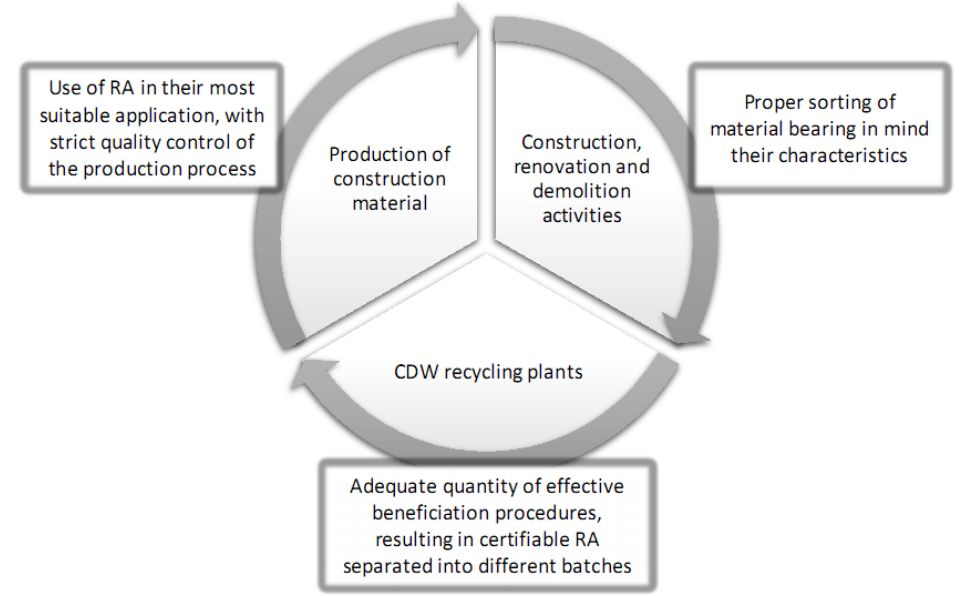
Figure 6. Life-cycle of RCA [82,83]. Reprinted from Ref. [82].